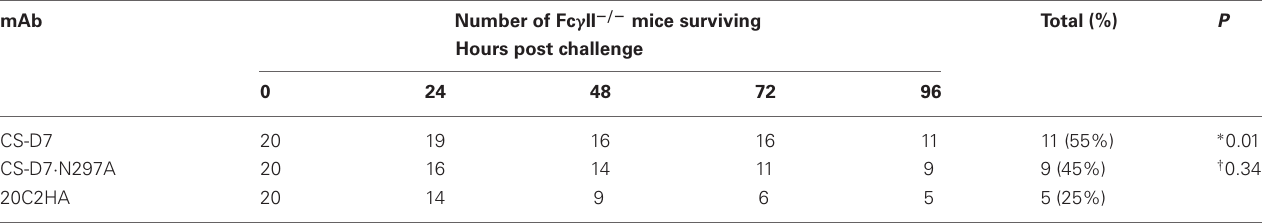
∗ Comparison of survival with CS-D7 versus survival with isotype control 20C2HA. † Comparison of survival with CS-D7 · N297A versus survival with CS-D7. Table 5 | Passive immunization and challenge of complement deficient mice. mAb